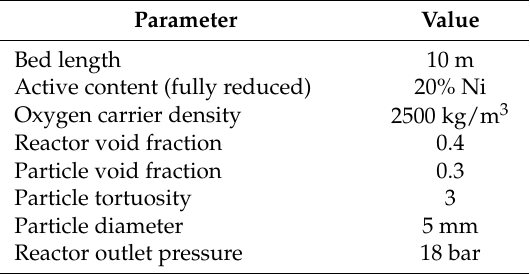
Table 3. Miscellaneous simulation parameters used in the PBCLR